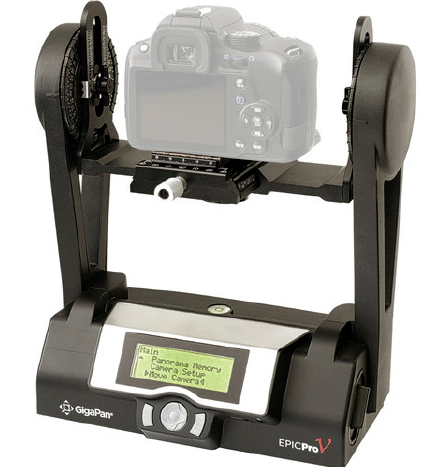
Figure 2. Panoramic instrument of GigaPan EPIC Pro V.